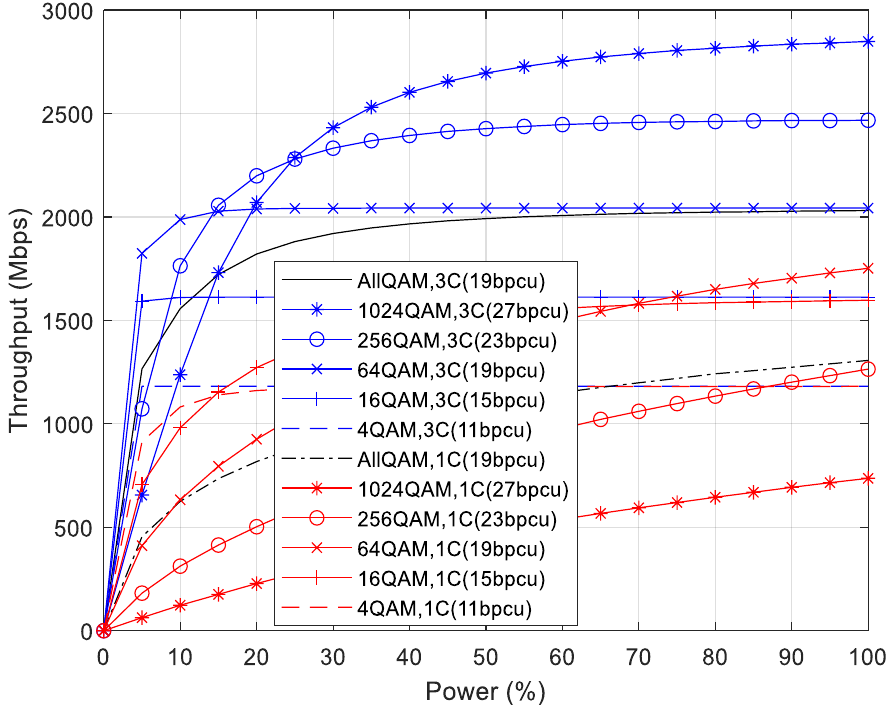
Figure 9. Average throughput vs percentage of transmitted power for N tx = 17 antennas / user and N rx = 16 antennas /